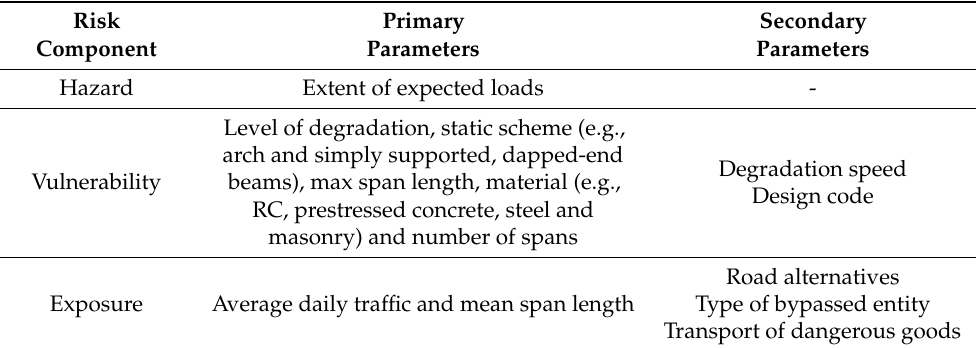
Table 2. Parameters influencing structure and foundations